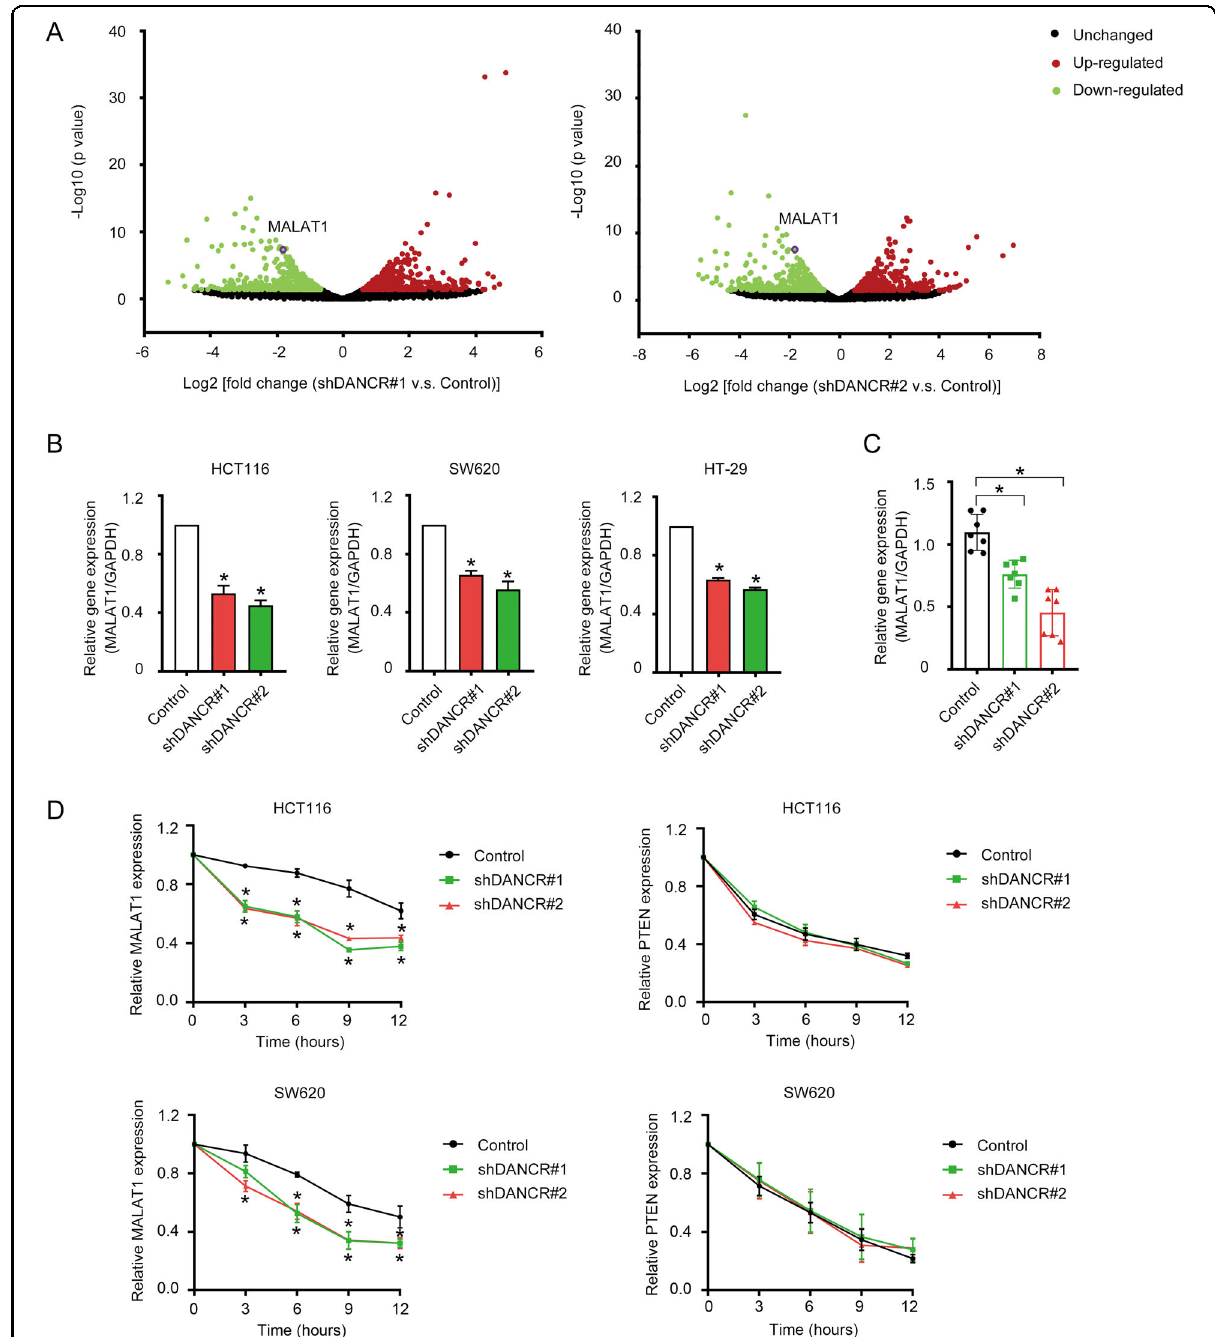
Fig. 4 DANCR modulated MALAT1 expression by enhancing the RNA stability of MALAT1. A Differentially expressed genes upon DANCR knockdown in HCT116 cells are shown in volcano plots. X axis: Log 2 [fold change (shRNA vs. Control)]; Y axis: − Log 10 ( p value). B Decreased expression of MALAT1 upon DANCR knockdown was validated by qRT-PCR in HCT116, SW620, and HT-29 cells. * p < 0.05. C Decreased expression of MALAT1 upon DANCR knockdown was validated using qRT-PCR in xenograft tumor tissues ( n = 7 for each group). * p < 0.05. D The expression levels of MALAT1 (left) and PTEN (right) upon DANCR knockdown in HCT116 and SW620 cells were detected by qRT-PCR at 0, 3, 6, 9, and 12 h post- treatment with Actinomycin D. * p <